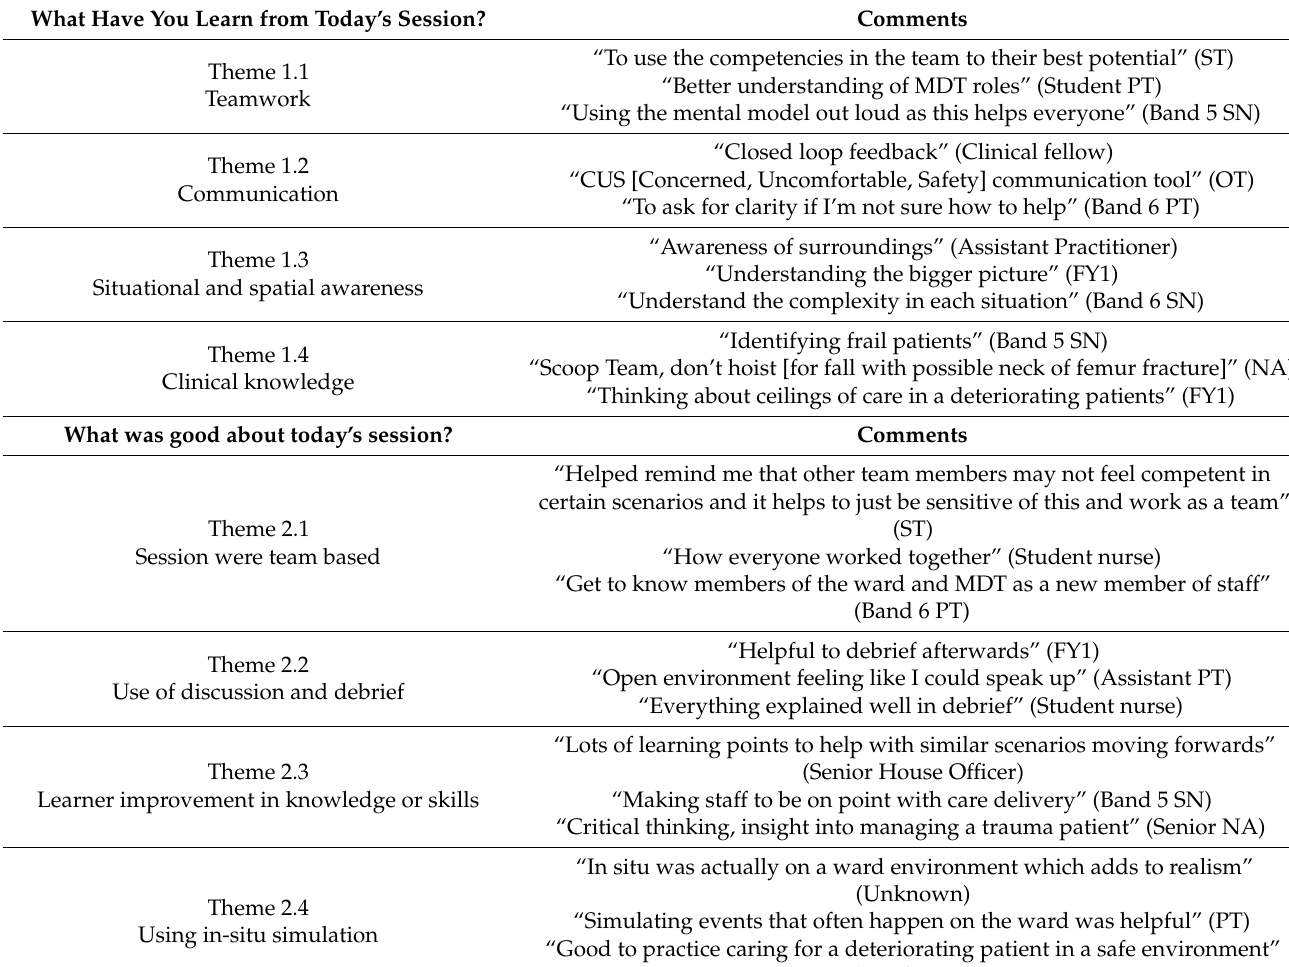
Table 2. Thematic analysis of free-text responses to questions about the assessment of learning from in situ simulation training sessions with representative comments from